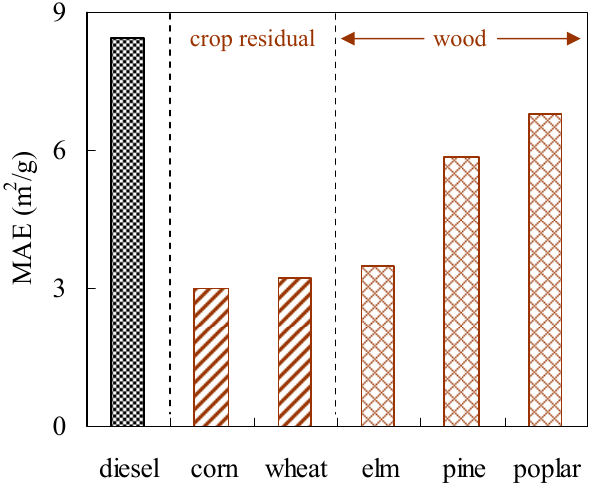
Figure 4. MAE of diesel exhaust and biomass smoke samples. Fig. 4. MAE of diesel exhaust and biomass smoke samples.